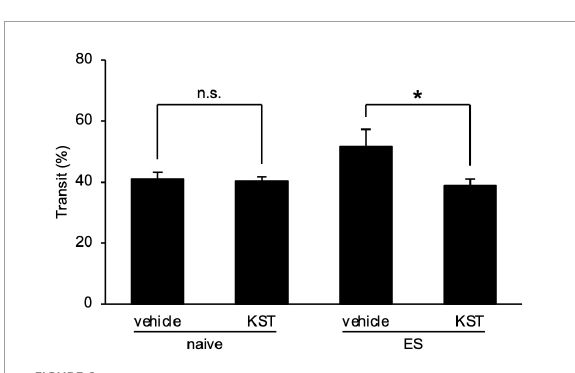
FIGURE6 Keishikashakuyakuto normalizes chronic vicarious social defeat stress-induced intestinal peristaltic change. Keishikashakuyakuto (KST; 1 g/kg, p.o.) attenuated the intestinal transit ratio in ES mice, but not in naive mice, in the charcoal meal test on day 12. Data are presented as means ± s.e.m., and analyzed using two-way factorial ANOVA, followed by Bonferroni’s post hoc test. * p < 0.05. naive, n = 10; ES, n =